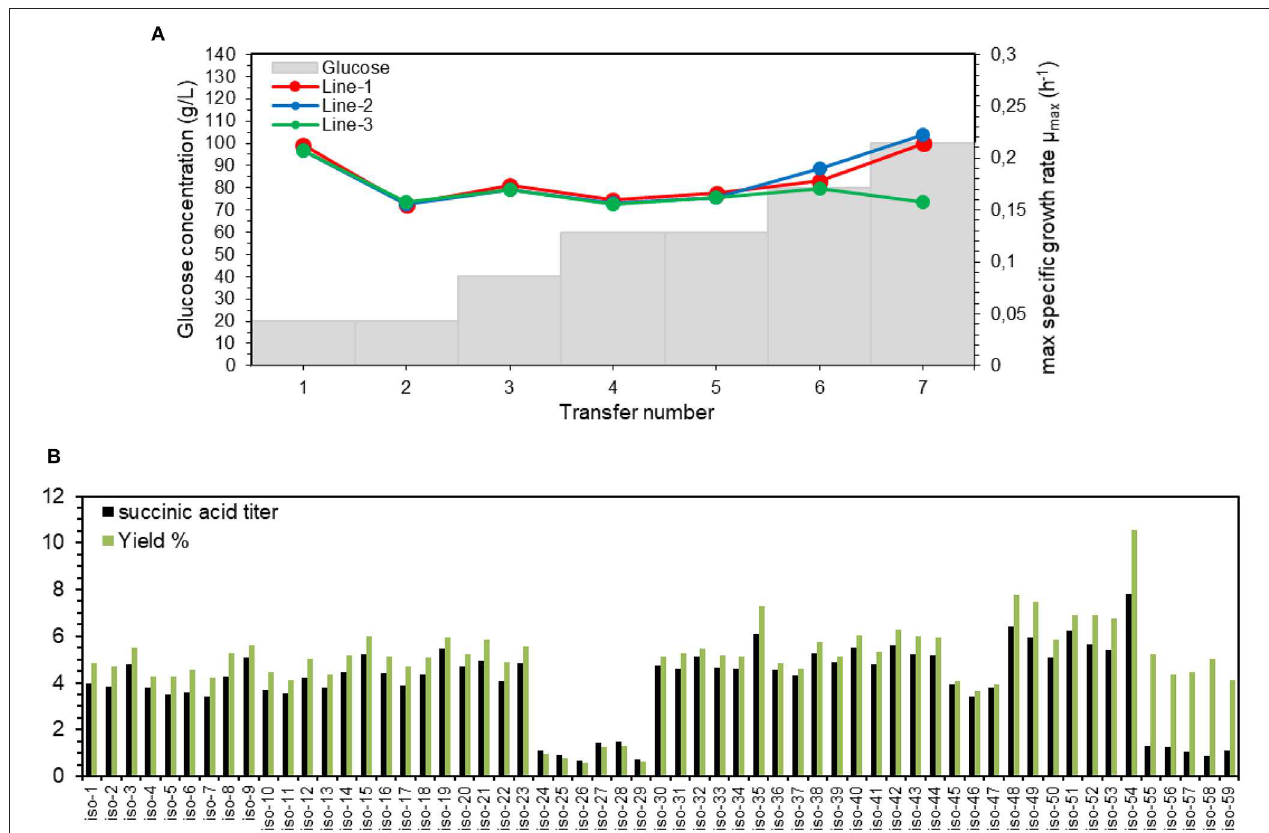
FIGURE 4 | Adaptation of succinate-producing strain ST8578 to high concentrations of glucose. (A) Maximum specific growth rates ( µ max ) are shown as the strains are serially transferred to media with higher glucose concentrations. (B) Succinate titer and yield of multiple adapted isolates of ST8578 was assessed in deep-well plates on YP medium with 100 g/L glucose after 48h incubation (B) . The isolate nr. 54 (iso-54) was chosen as the best